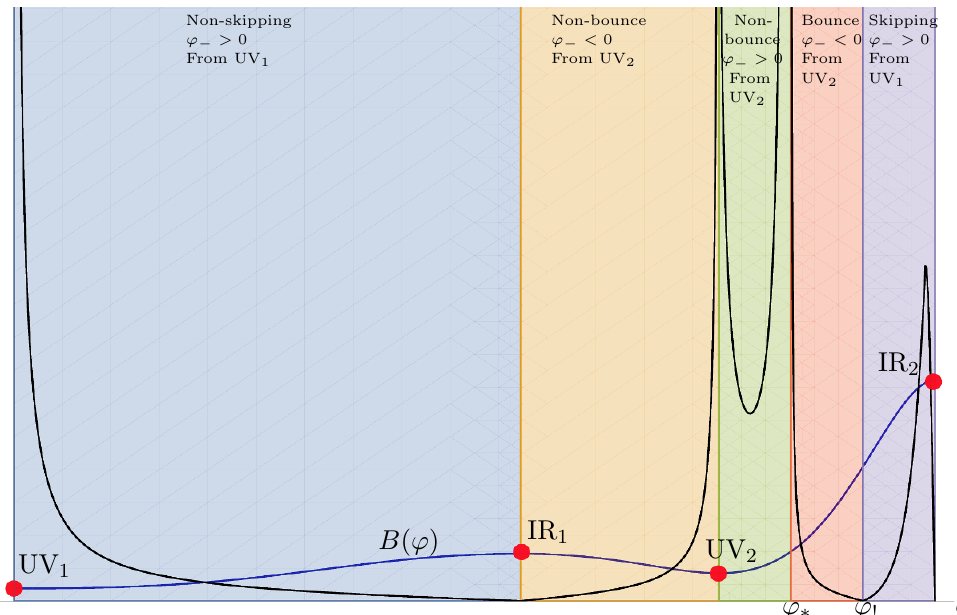
Figure 30. Dimensionless curvature R vs. (cid:13)ow end point ’ 0 . The leftmost blue region is the IR region where non-skipping (cid:13)ows from UV 1 can end. The rightmost purple area is the IR region for skipping (cid:13)ows from UV 1 . The light brown region is the IR region for (cid:13)ows starting from UV 2 with a negative source and no bounces along the (cid:13)ow. The green area is the IR region for (cid:13)ows starting from UV 2 with a positive source. The red region is the IR region for (cid:13)ows from UV 2 with a negative source but which exhibit a bounce. The blue line is the critical curve B ( ’ ) =